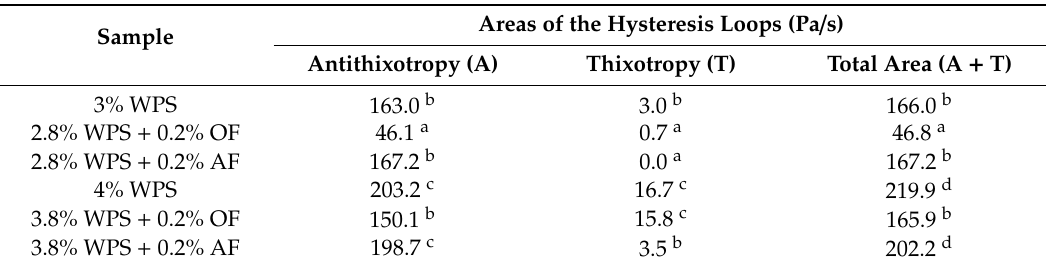
Table 3. Areas of hysteresis loops of starch pastes and their mixtures with OF and AF.